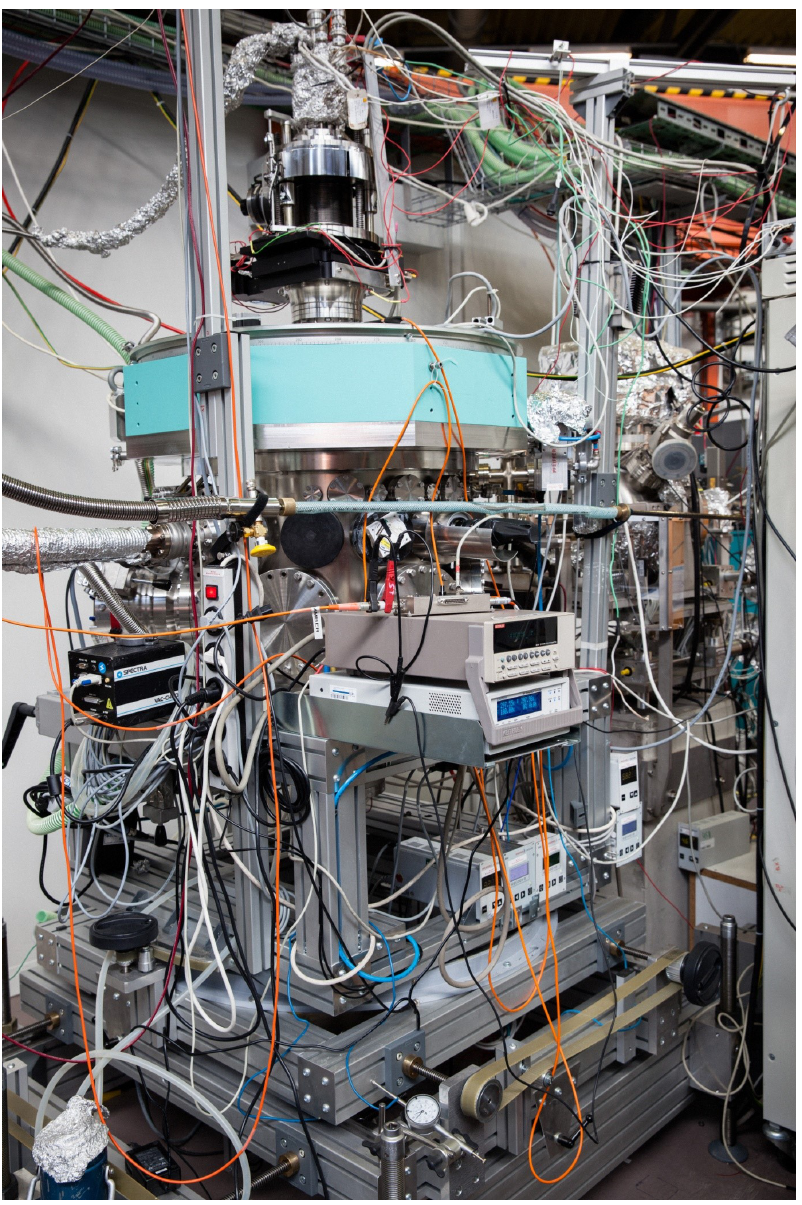
Figure 3: View of the XUV Diffractometer with the detector circle painted in the typical Huber